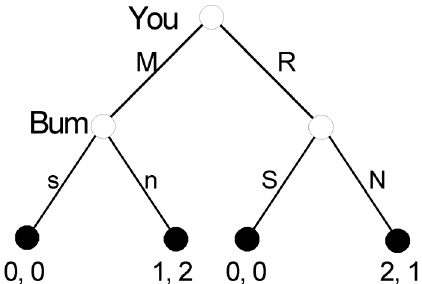
Figure 3. Crazy Bum In Crazy Bum, there are three Nash equilibria. ( M , nS ) and ( R , nN ) intuitively correspond to ( M , S ) and ( R , N ) in the original Bum. The third equilibrium, ( R , sN ), is the weirdest one. In this equilibrium you refuse to make the donation, and the bum doesn’t shoot himself. However, he would shoot himself if you gave him the money! The behavior associated with the strategy profile ( R , sN ) makes even less sense that the one associated with the equilibrium based on an incredible threat. And yet ( R , sN ) is a Nash